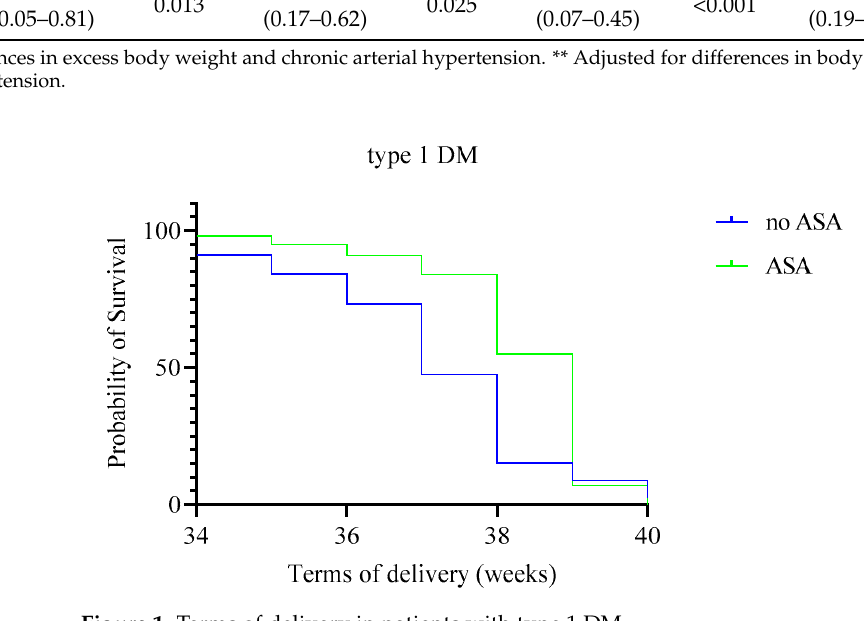
Figure 1. Terms of delivery in patients with type 1 DM.